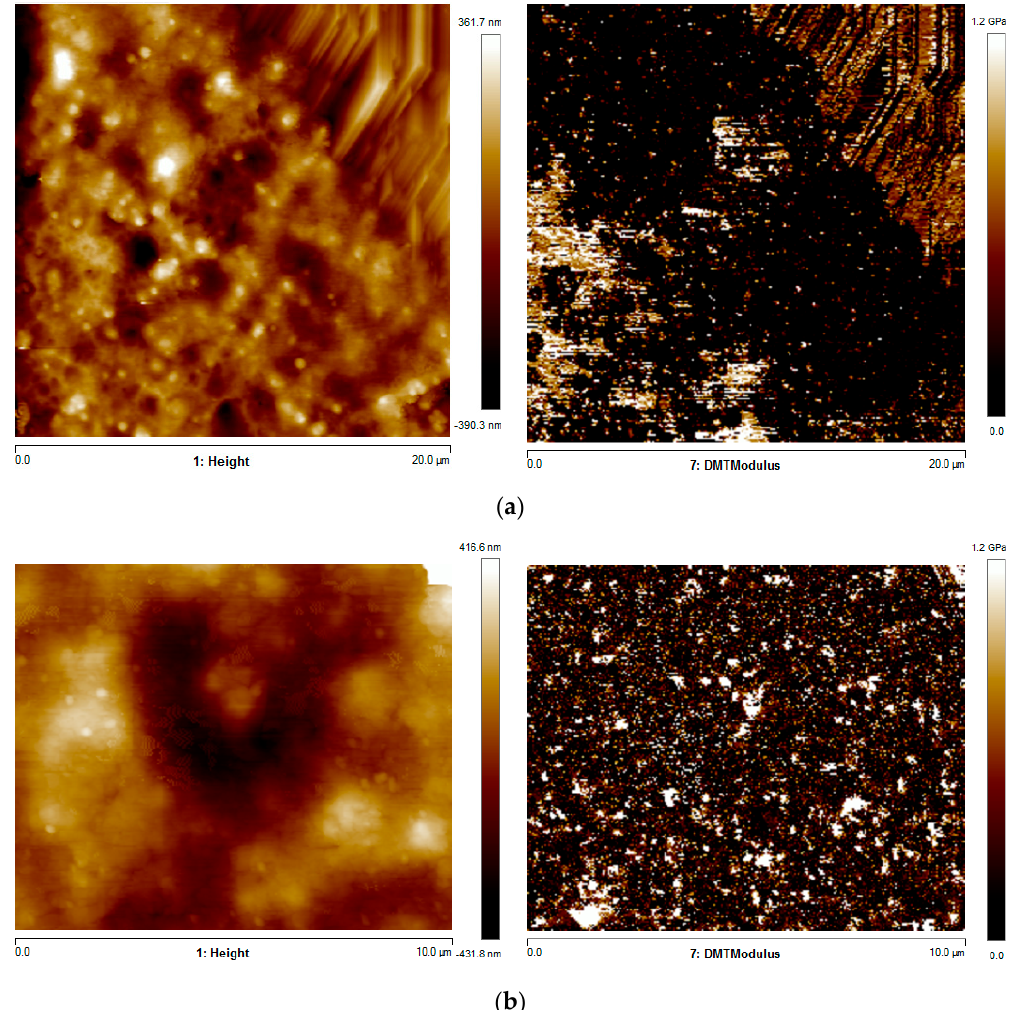
Figure 10. AFM height and elastic modulus maps of the specimens F in the ( a ) topmost and ( b ) central parts.